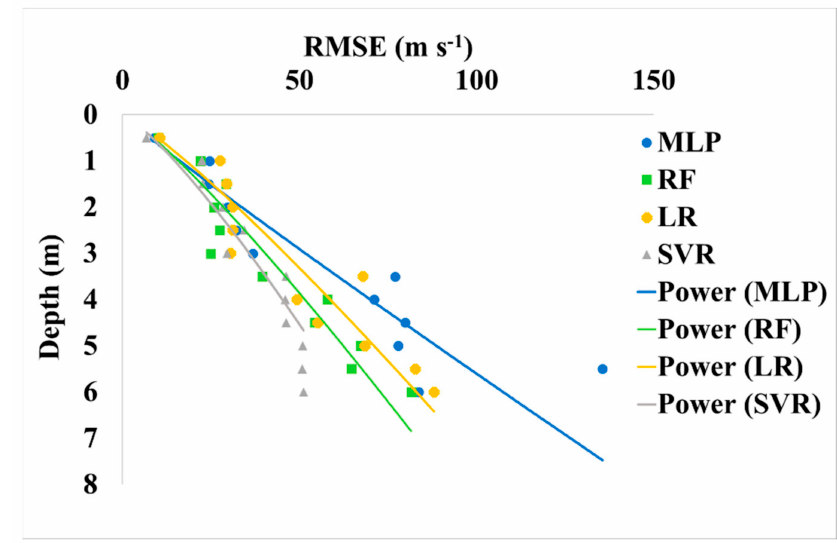
Figure 18. RMSE vs. depth for all algorithms.